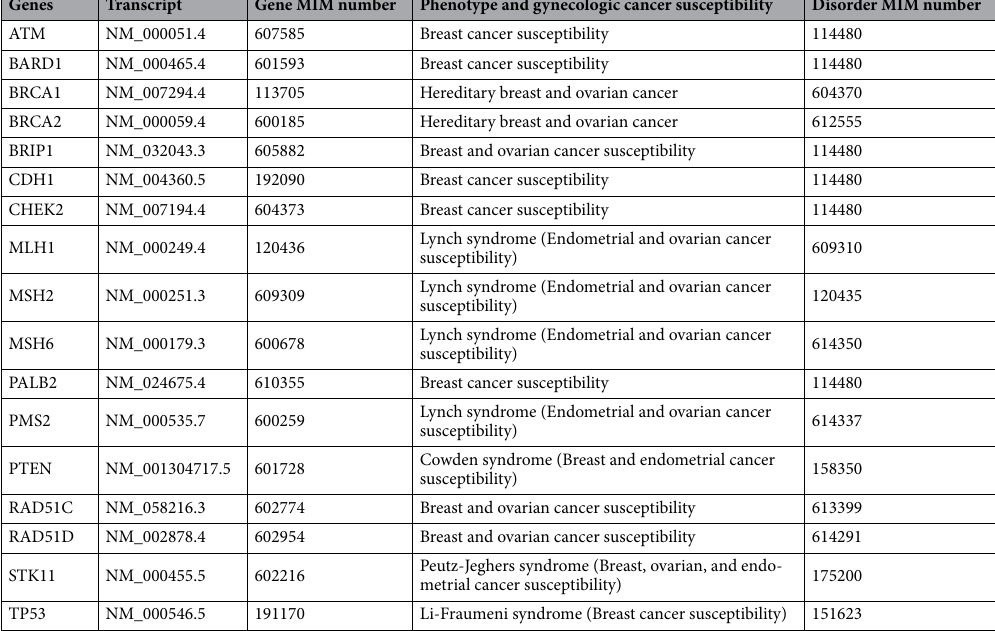
Table 1. Genes and associated cancer